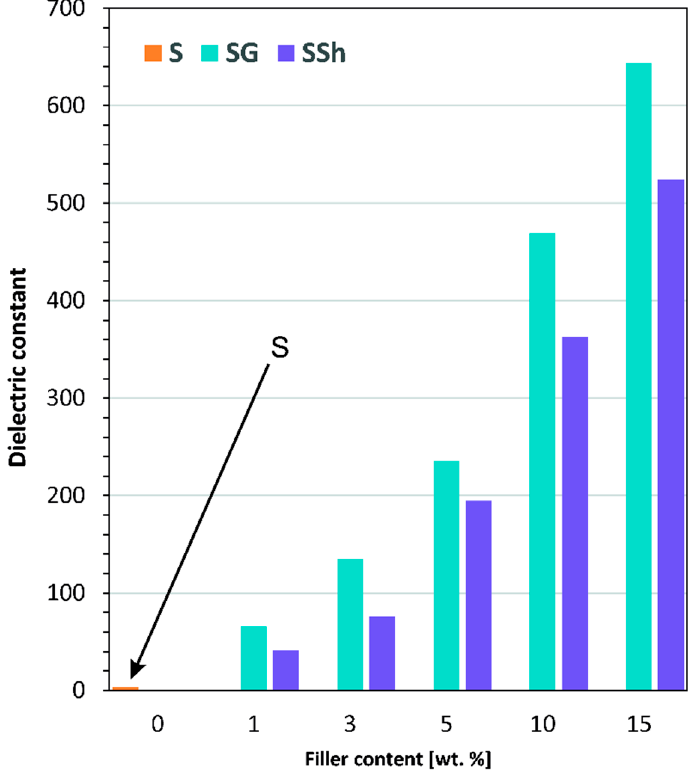
Figure 14. Comparison of dielectric constant for poly(dimethylsiloxane) (S) modified with graphite (SG) and shungite (SSh) at 1000 Hz.